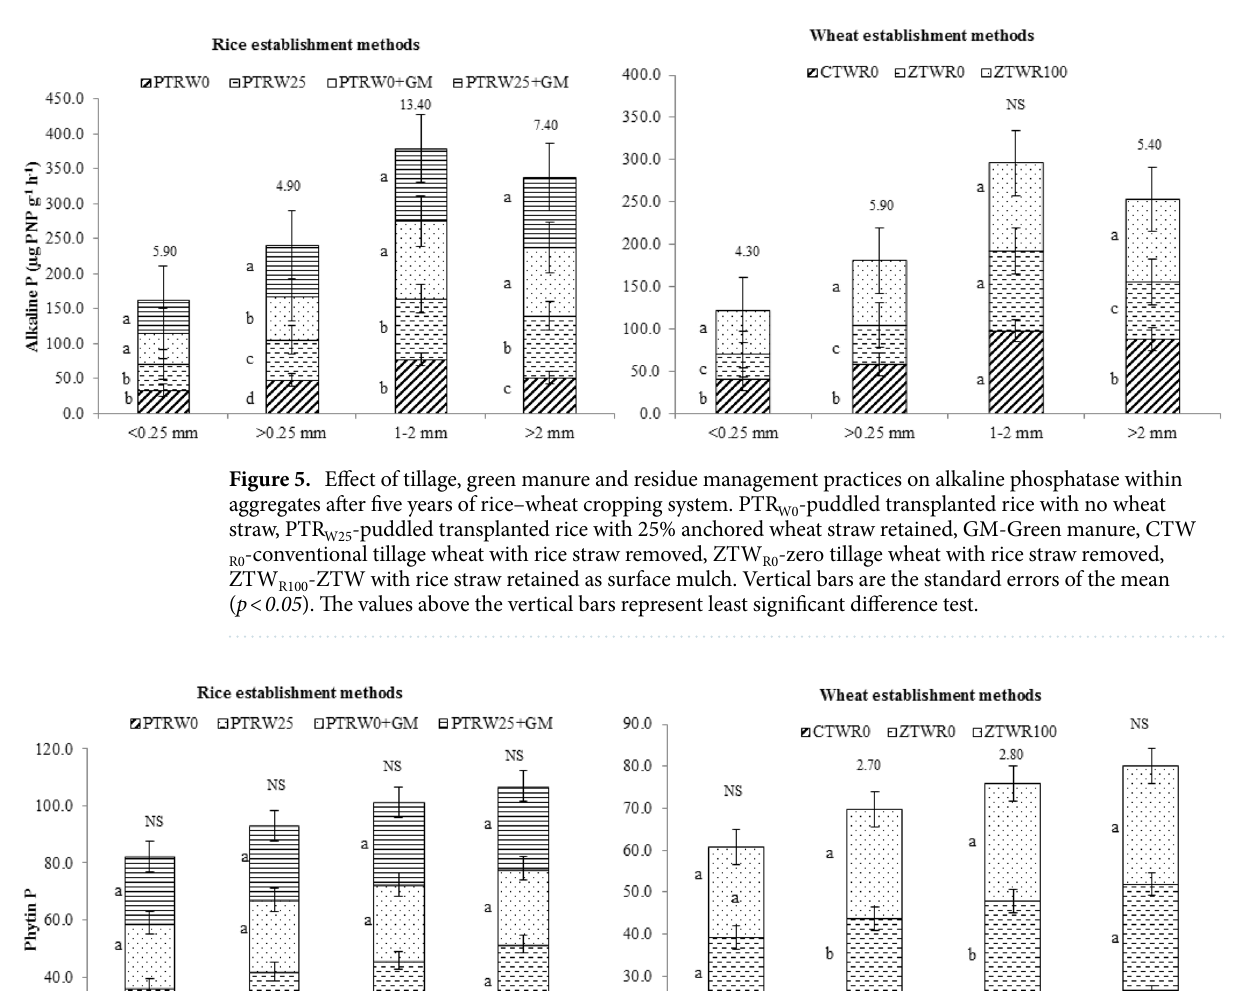
yield under ZT along with residue retention was 19% and 9% higher than ZT and CT without residue, respec- tively. Like grain yield, rice residue management practices showed a higher effect on grain yield attributes. The grains spike -1 was significantly higher under ZTW R100 than that of ZTW R0 . Grain yields of wheat were signifi- cantly related to total P and NaOH-P o fraction (r = 0.997** and 0.988*, respectively, p < 0.05) (Table 4). The avail- able P and alkaline phosphatase activity also exhibited significant relationships with the wheat grain (r = 0.968** and 0.949**, respectively, p < 0.05). Principal component analysis. Principal component analysis was performed to extract the most influ- ential soil parameters from each PC on the basis of eigen vector weight value or loading factors (Table 5). Only the highly weighted variables were retained in the minimum data set (MDS). The PC1 and PC2 explained 88.0% variability in the data set, where PC1 explained 74.68% and PC2 explains 13.32%. Hence, the bold-face values (NaOH-P o and NaHCO 3 -P i for PC1, HCl-P for PC2) were considered to be highly weighted eigen vectors and were initially selected in the MDS. The amount of variability explained by PC1 was 74.7%, with an eigen value of 7.47, which includes NaOH-P o , with the highest positive factor loading value (0.95), and NaHCO 3 -P i (0.93) (Table 5). The component PC2 explained variance of about 13.3% and eigenvalue of 1.33 with the highest posi-